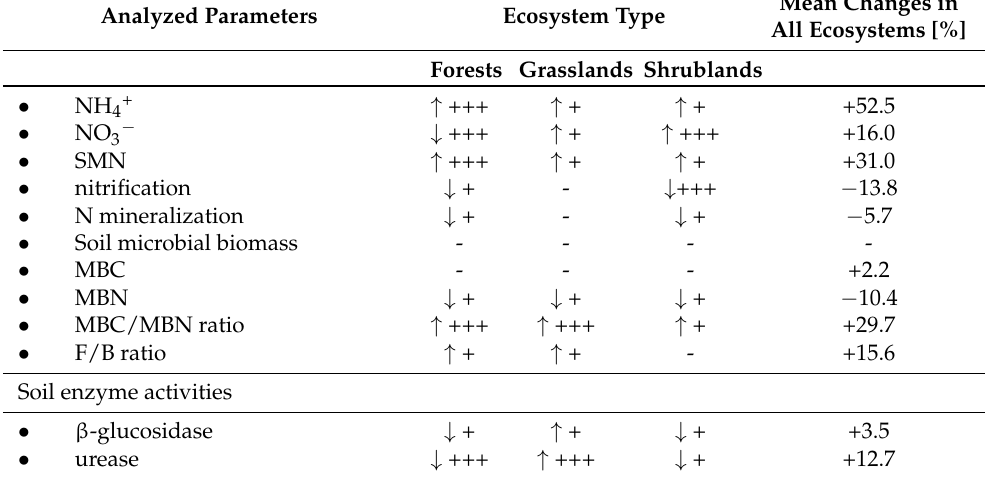
Table 1. Cont. Analyzed Parameters Ecosystem Type